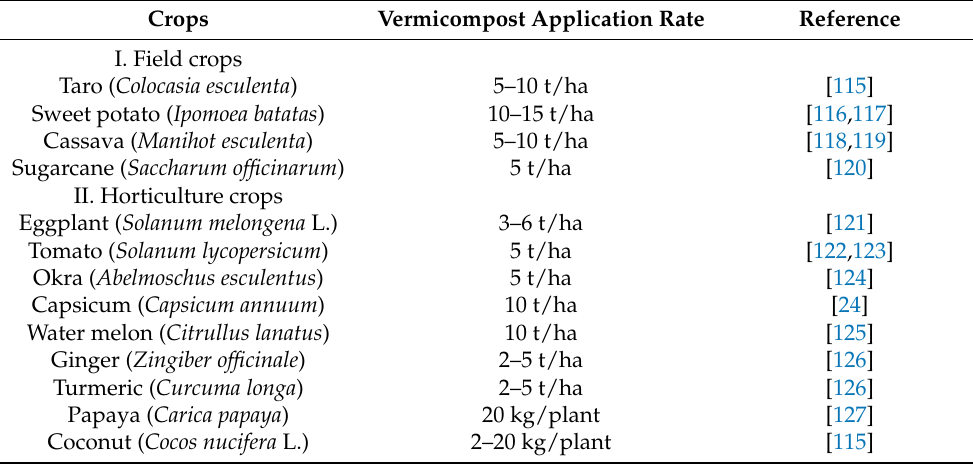
Table 4. Potential South Pacific Islands crops that might benefit from vermicompost